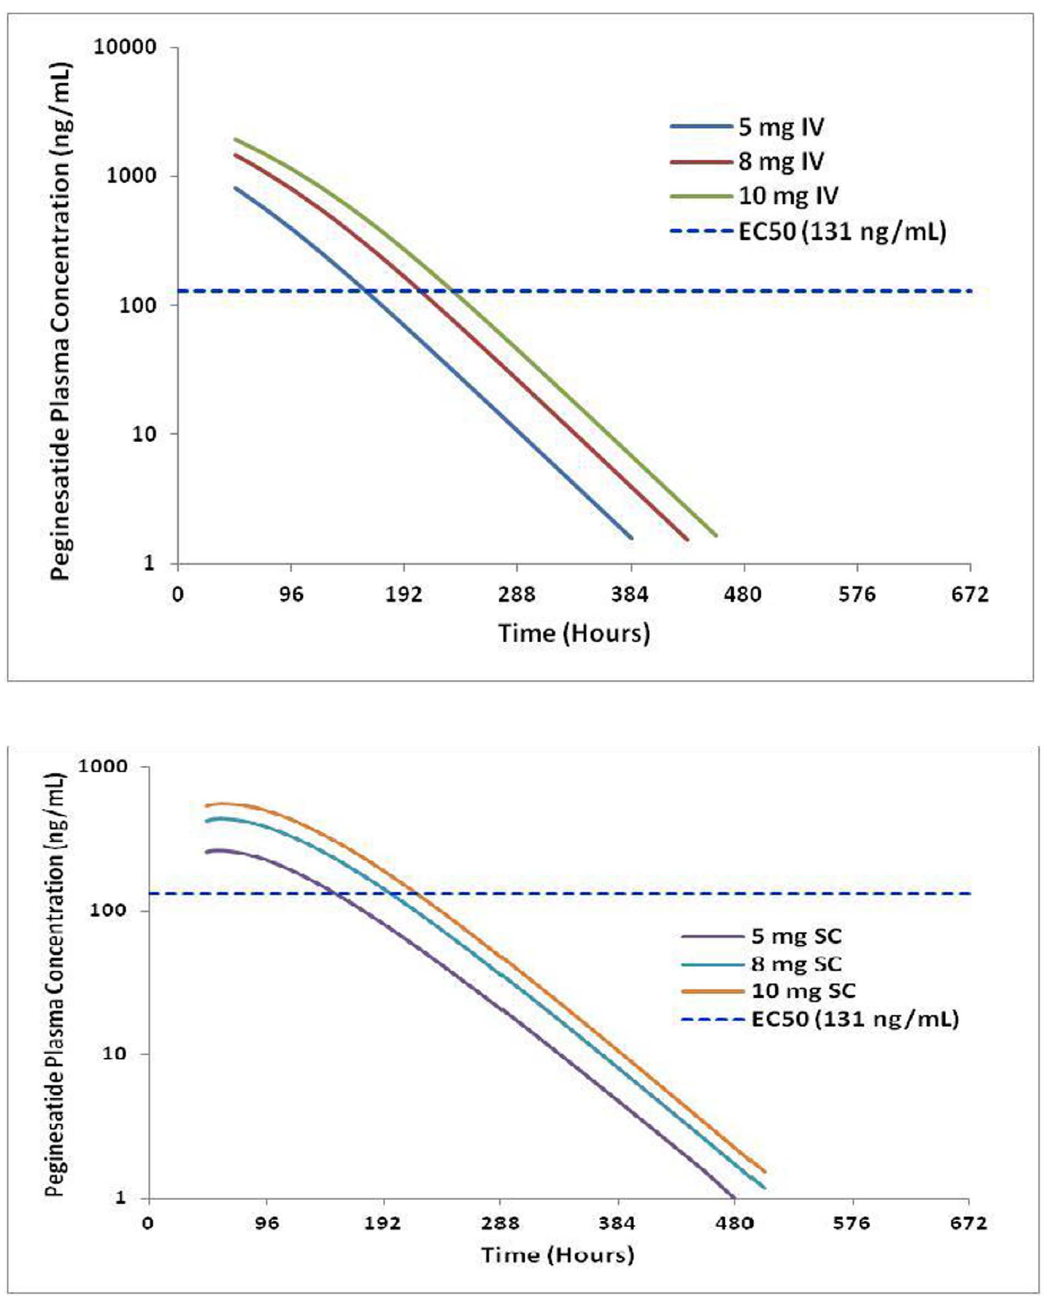
Figure 6. Simulated concentration-time profile of peginesatide following administration of a single 5, 8, and 10 mg every 4 week IV (top panel) and SC (bottom panel) dose. EC50 values reflect the EC50 value estimated for the base PK-PD model.